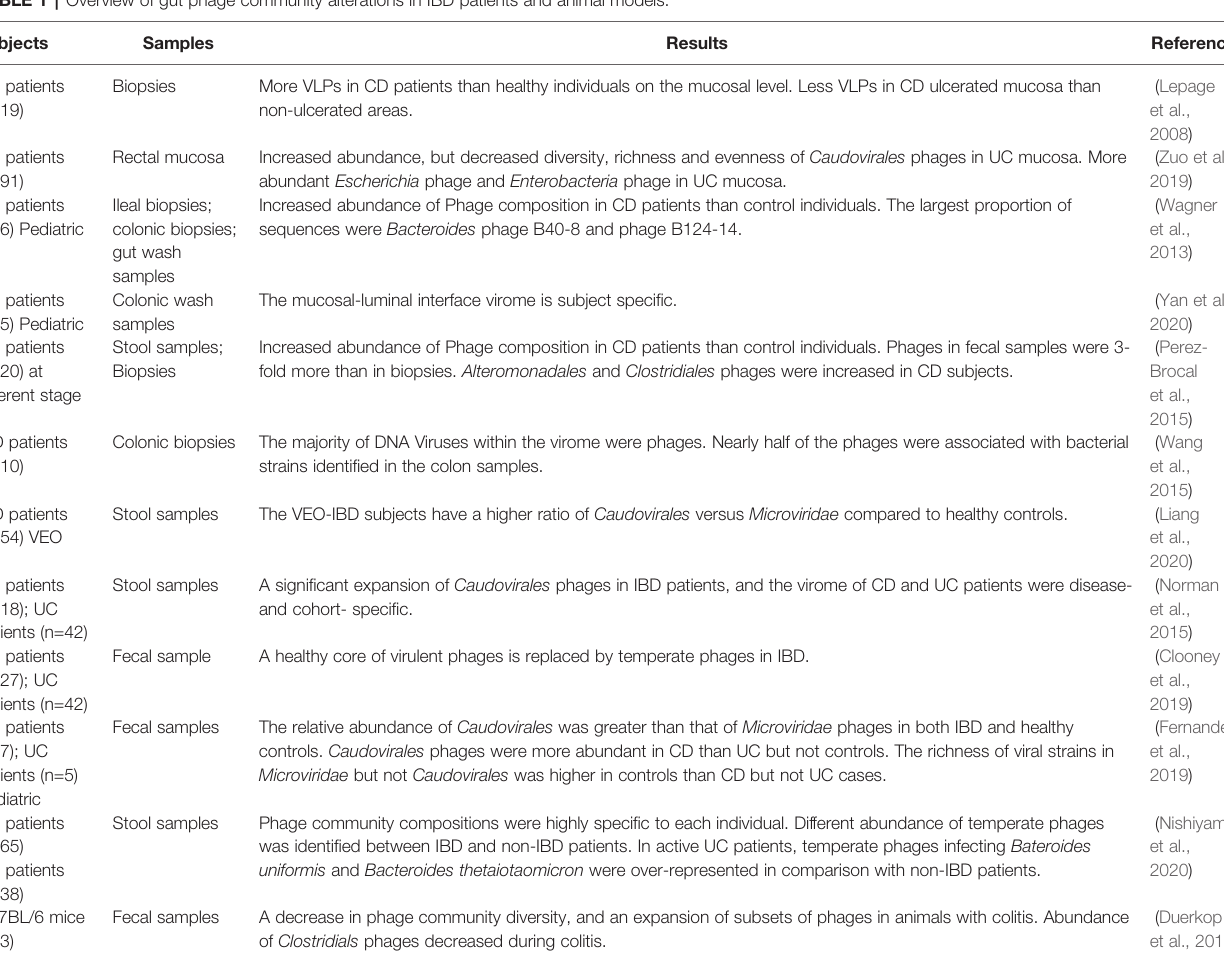
TABLE 1 | Overview of gut phage community alterations in IBD patients and animal